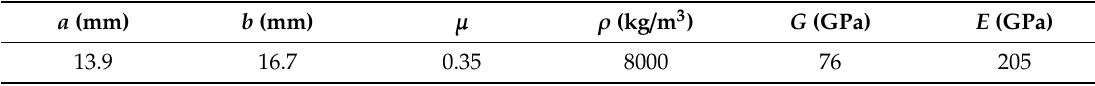
Table 1. Material and geometric parameters of the given